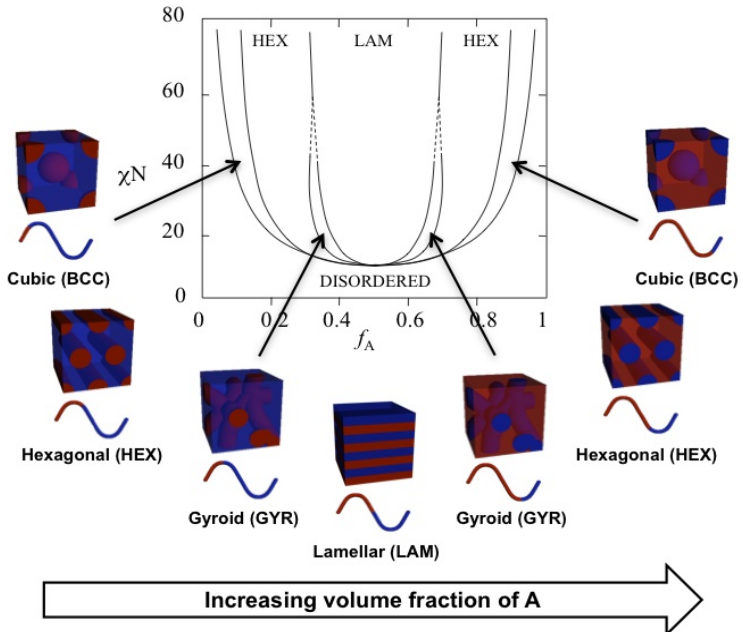
Figure 3. Theoretical phase diagram and corresponding morphologies for diblock copolymers. The phases are indicated as follows: body centred cubic (BCC), hexagonal cylinders (HEX), gyroid (GYR) and lamellar (LAM). f is the volume fraction of polymer A block A,  the Flory-Huggins interaction parameter and N the total degree of polymerisation. Adapted with permission from [33]. Copyright 1996 American Chemical